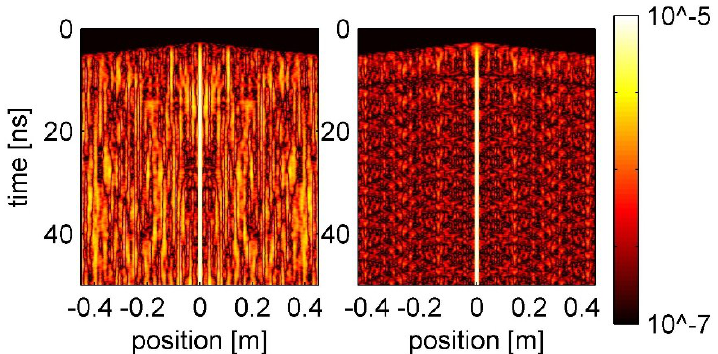
Figure 3. Calculated magnitude of the stimulated acoustic wave density fluctuations (in units of kg/mm 3 , see color bar) as a function of time and position within 1 m of fiber [21]. The pump and signal waves were jointly modulated by a high-rate binary phase sequence. A pseudo-random bit sequence (PRBS) was used in the left panel, and a perfect Golomb code was used in the right panel. Both codes were 63 bits long with bit duration of 100 ps. Stationary stimulation of the acoustic wave may be observed at a narrow correlation peak at the center of the fiber. The magnitude of residual off-peak acoustic waves is considerably reduced with the employment of the Golomb code. Reproduced with permission from [21], Optical Society of America, 2012.